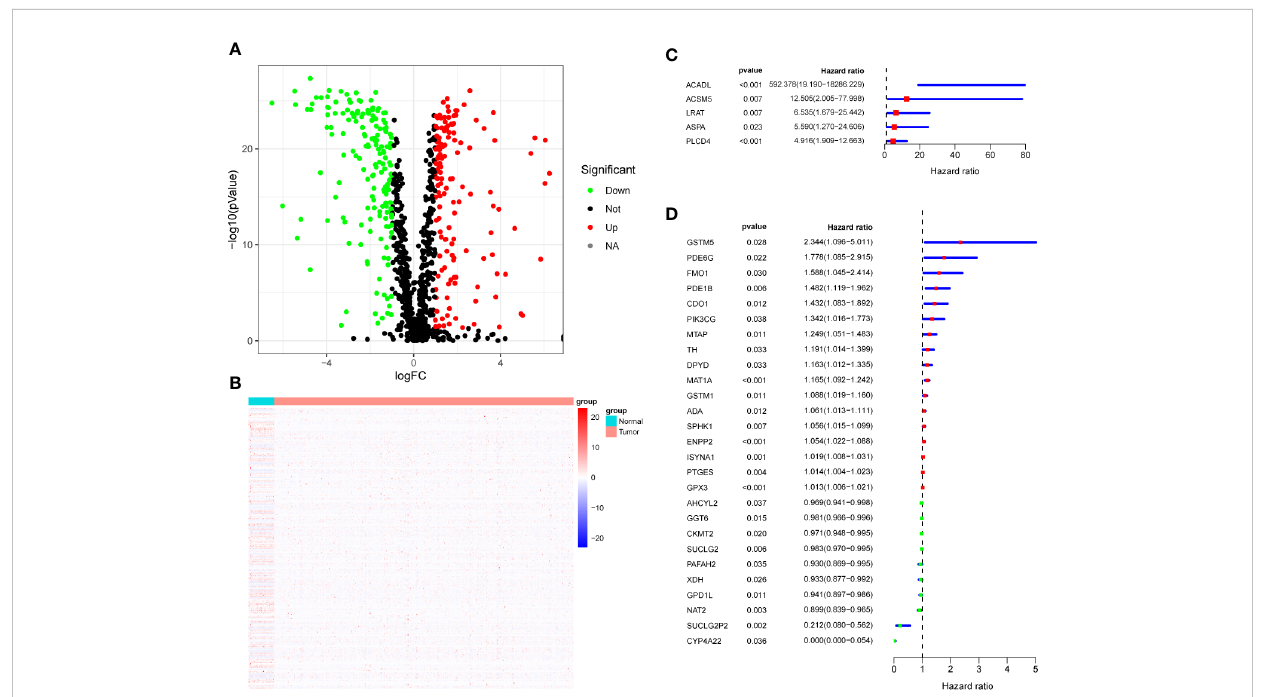
FIGURE 1 HMRG Screening. (A) Volcano plot showing differentially expressed metabolic genes. (B) Heatmap showing differentially expressed metabolic genes. (C, D) Forest plots showing univariate Cox analysis of DEG survival